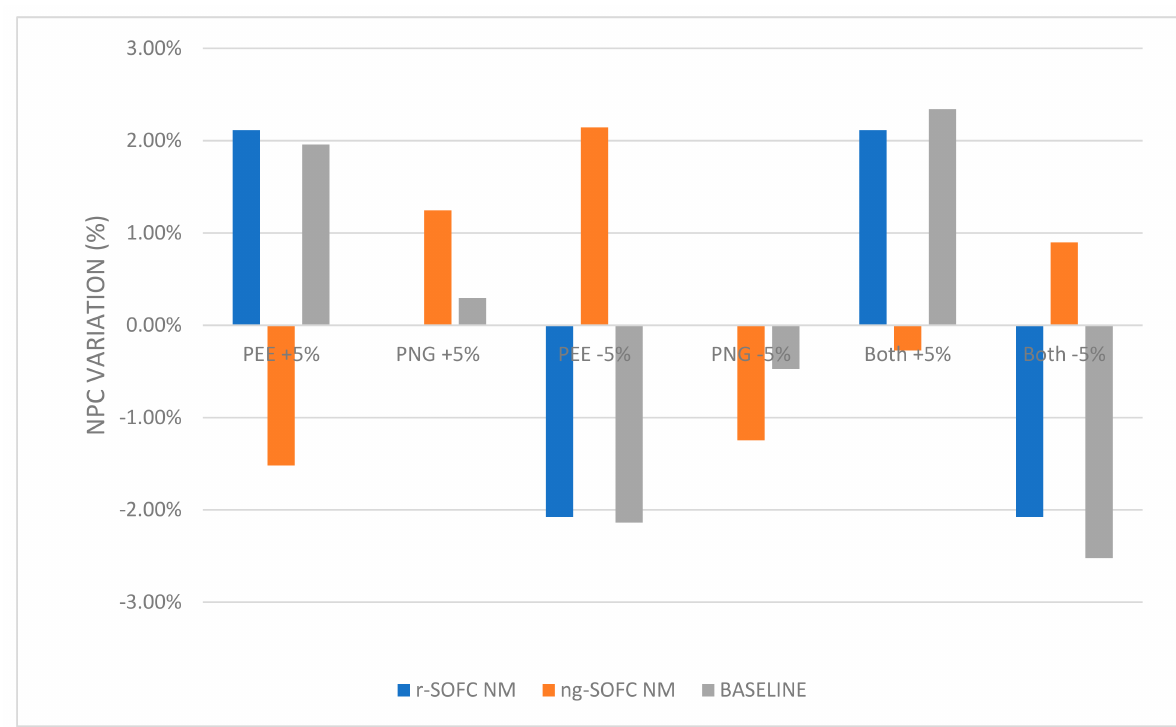
Figure 5. Sensitivity analysis (NM) with ± 5% variations of energy price. P EE : price of electricity.P NG : price of natural gas. Both: price of electricity and price of natural gas.